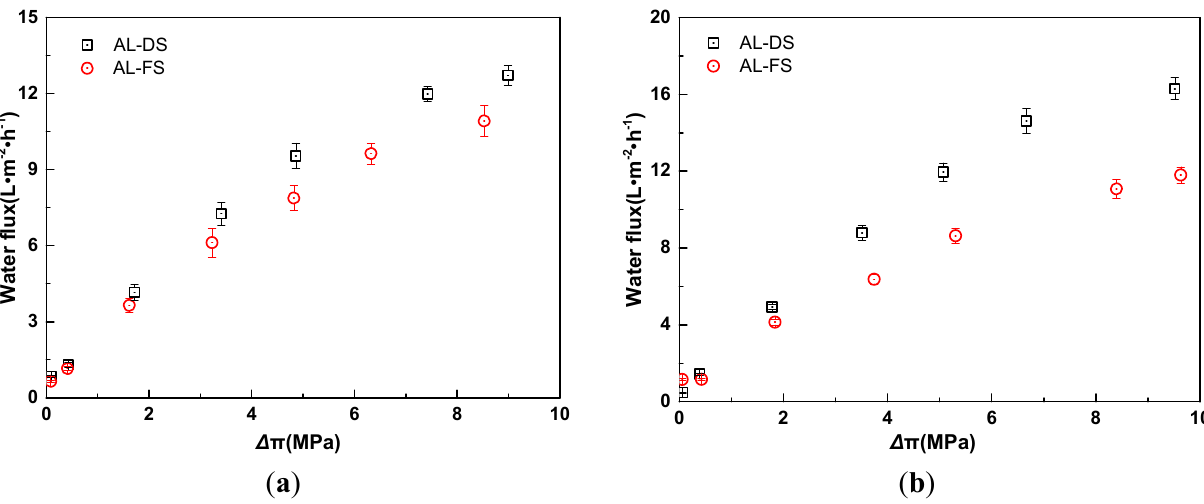
/ C = 8; ( b ) C = 0.01 M. The d f f